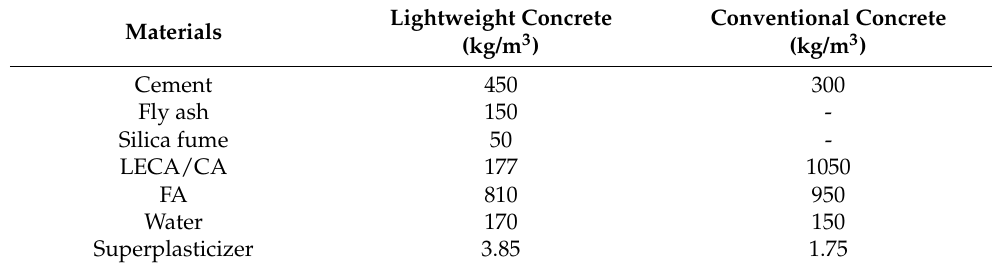
Table 5. Concrete mix